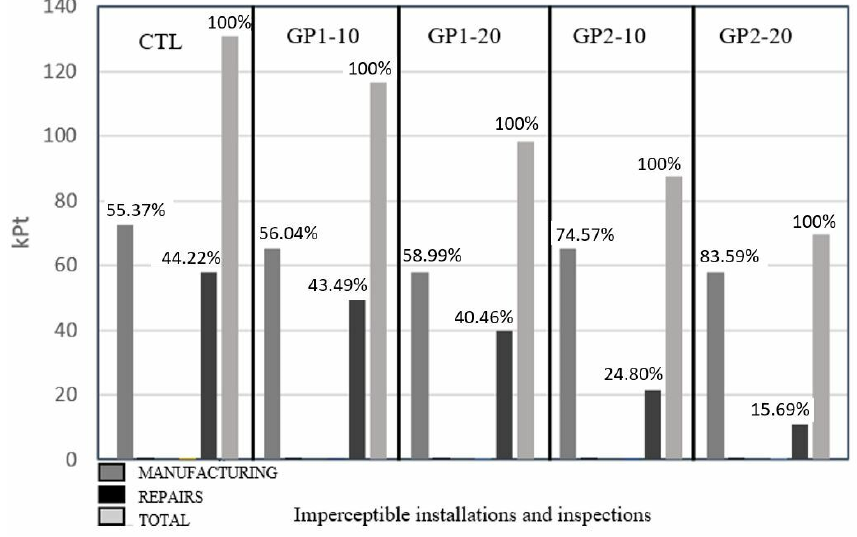
Figure 19. Total endpoint environmental impact in 100 years.